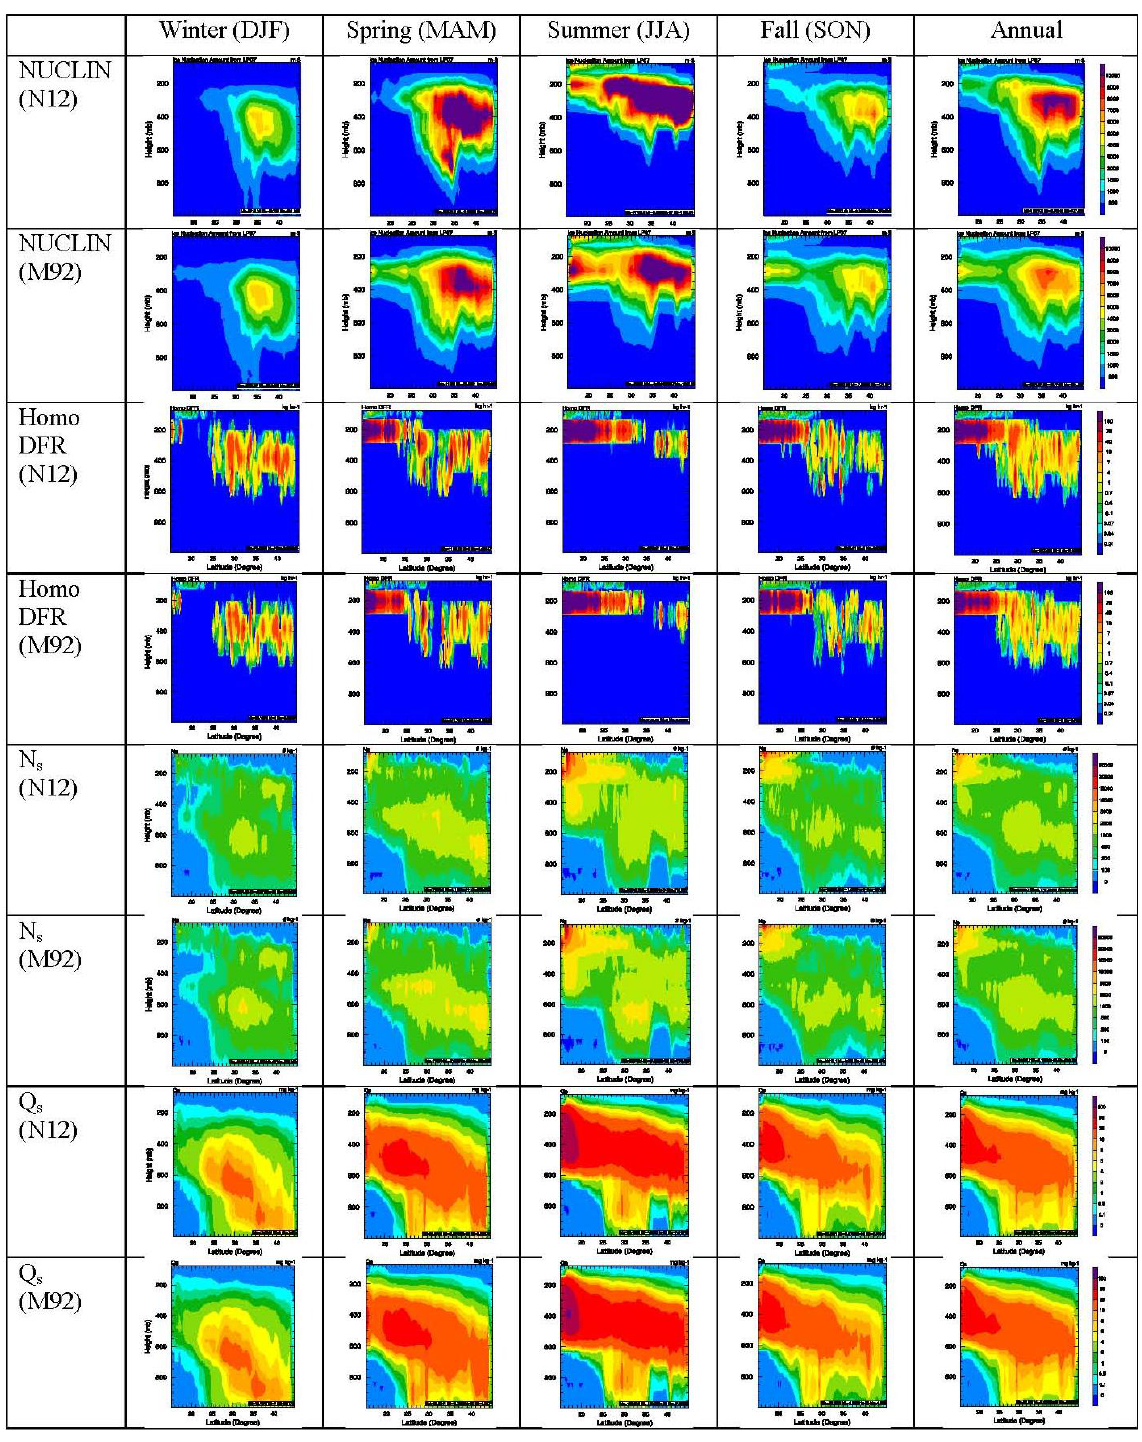
Figure 4. Zonal mean distributions of NUCLIN, Homo DFR, N s , and Q s for the 2006 simulations with N12 and M92 over the vertical domain